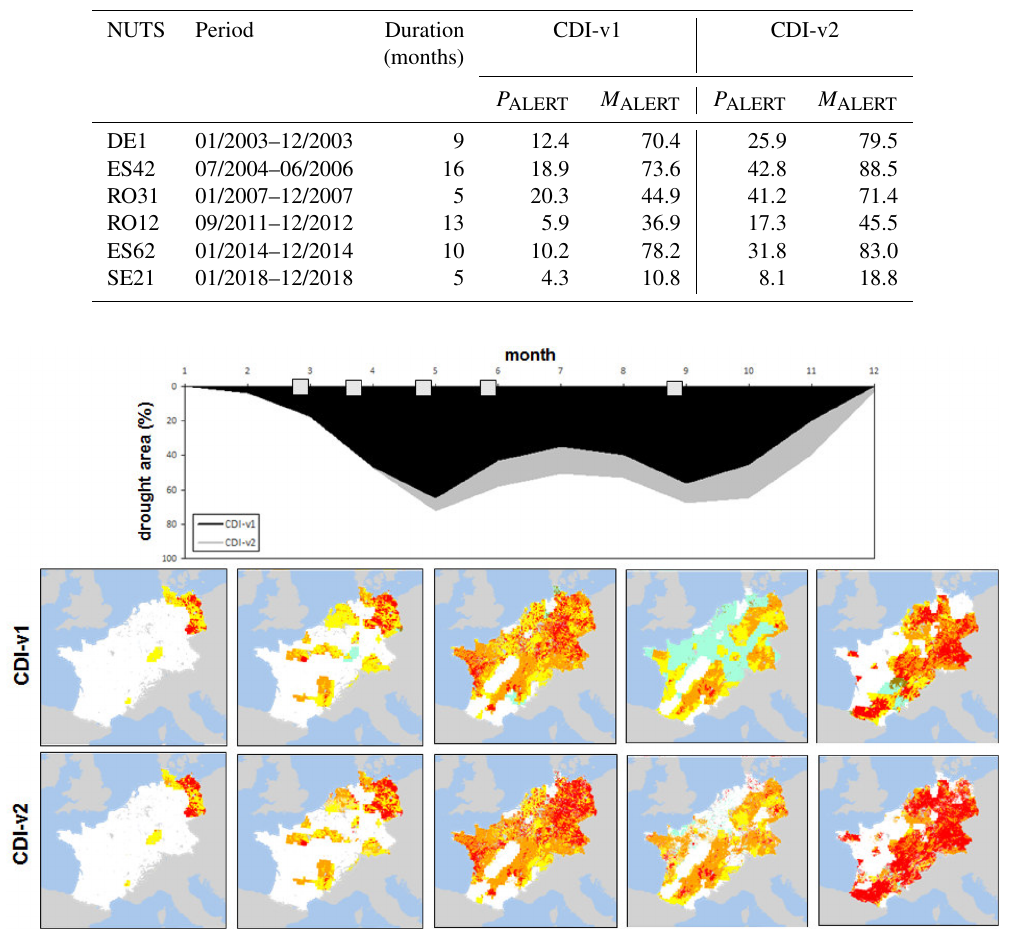
Figure 7. Temporal evolution of the 2003 central European drought according to the two versions of the CDI. The upper plot shows the percentage of the area under drought (WATCH + WARNING + ALERT, in black for CDI-v1 and in grey for CDI-v2), whereas the lower images depict the spatial distribution of CDI-v1 (upper row) and CDI-v2 (lower row) for the selected dekads (demarked in the upper plot by the squares on the x